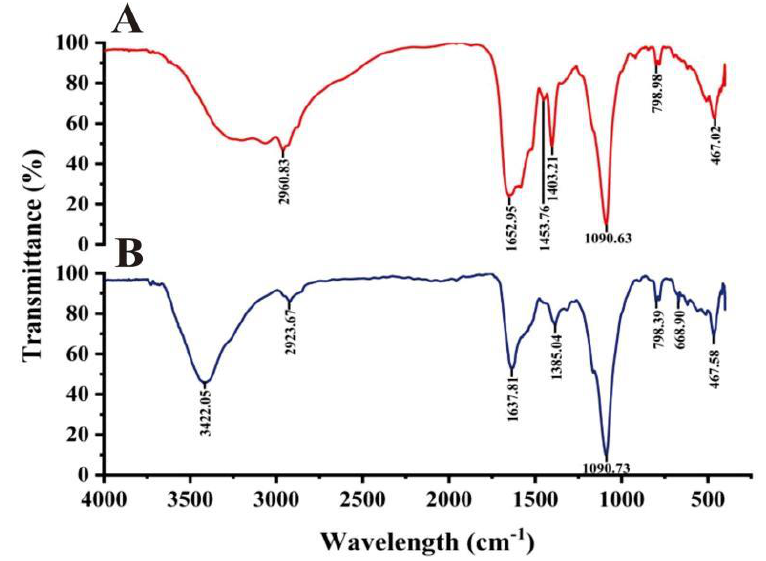
Figure 9. FTIR spectra recorded from microbially synthesized Ag@AgCl nanoparticles: cell-free su- pernatant ( A ) and biogenic Ag@AgCl nanoparticle solution ( B ).